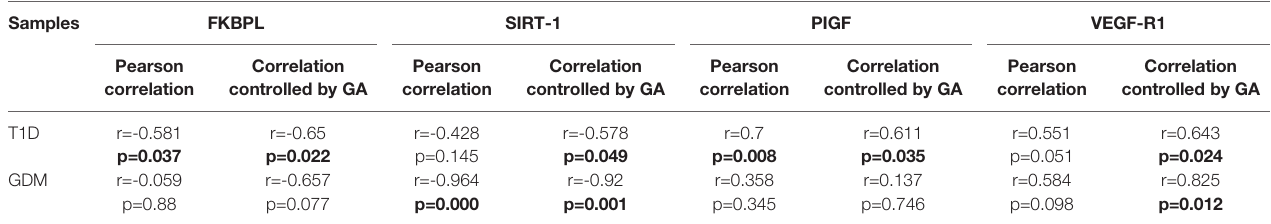
FIGURE 2 | Placental angiogenic balance is disrupted in T1D. Placental slides from women with T1D versus age, BMI and foetal sex matched controls were stained with (A) FKBPL, (B) SIRT-1, (C) PlGF and (D) VEGF-R1 primary antibodies, followed by staining with green Alexa fl our or red Cy3 secondary antibody. Six images per slide were taken at 20x magni fi cation and the mean fl uorescence quanti fi ed using Image J. Representative images inset. FKBPL/PlGF/SIRT-1: unpaired t-test, n=8; VEGF-R1: Mann-Whitney, *<0.05). ns, non-signi fi cant.